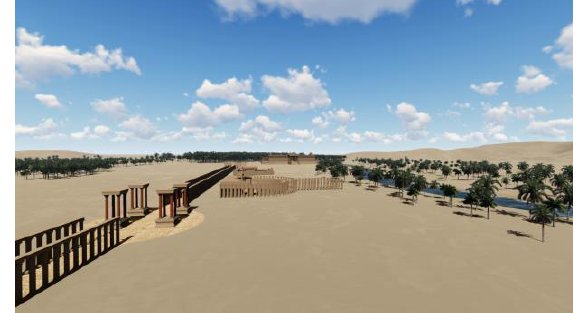
Figure 1. Center of the city was marked by a large tetrapylon After Triumphal Arch, colonnaded street made a turn of 30 degrees southwards (this part was never finished) with respect to this main road, and there was the Great Temple. (Fig 2)